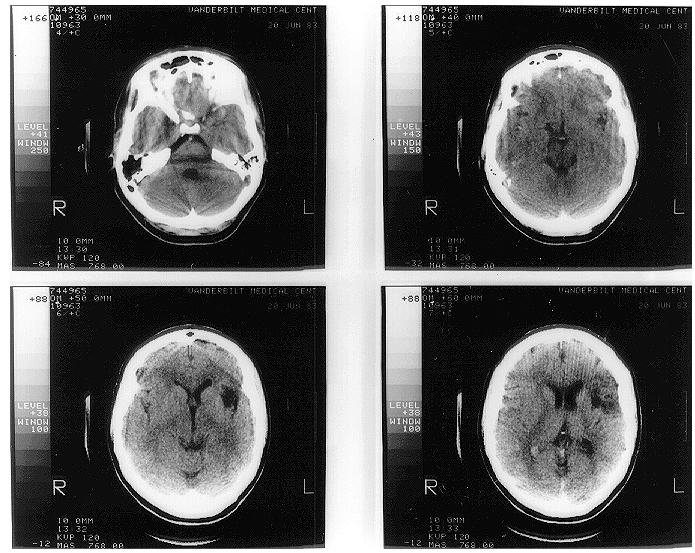
Fig. 2. CT scan cuts from Patient 2 (18 days post-onset), showing only a left frontal, cortical and subcortical opercular and insular infarction.